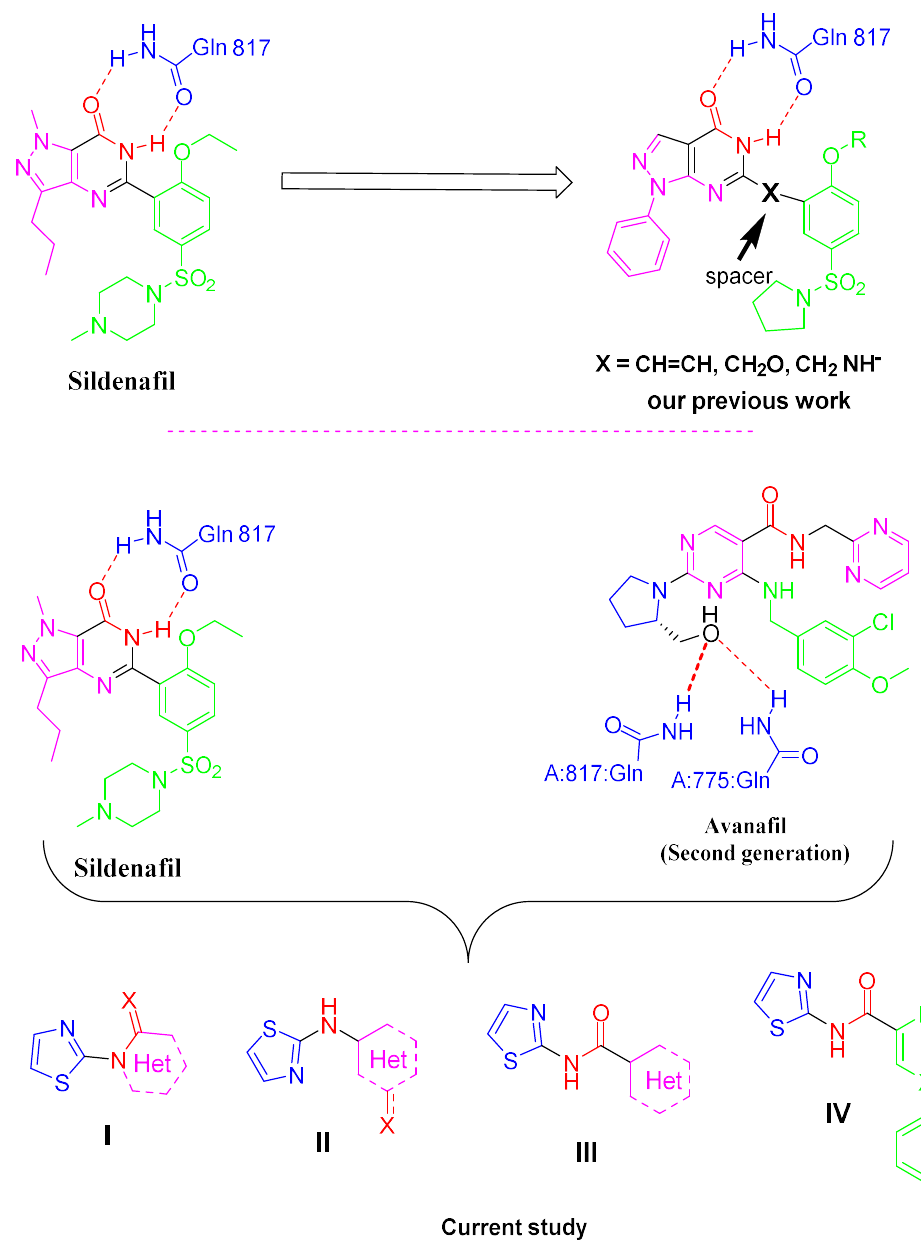
Figure 2. Medicinal chemistry design of current study.